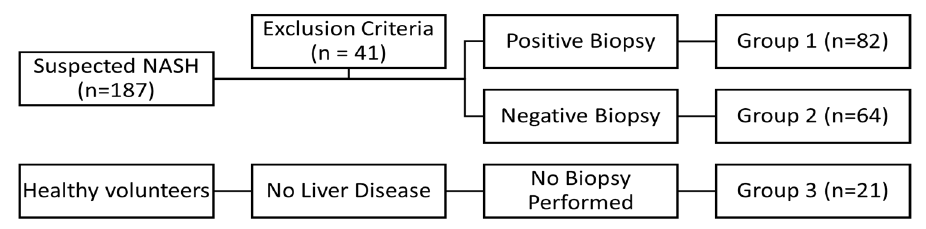
Figure 1. Study Figure 1. Study Design.